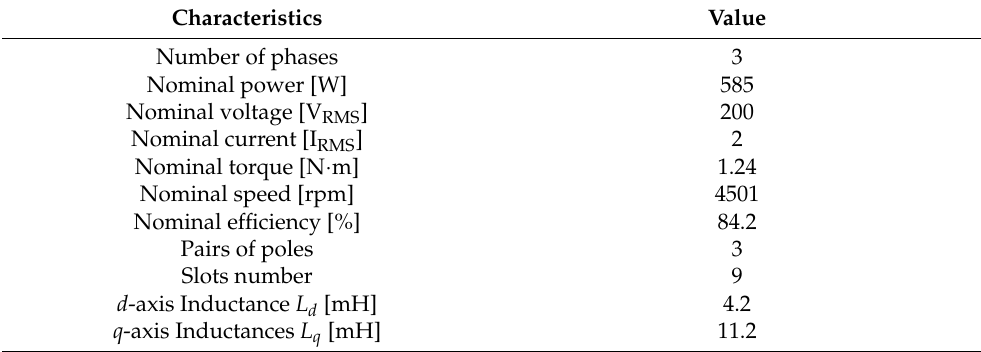
Table 1. PMSM Characteristics.